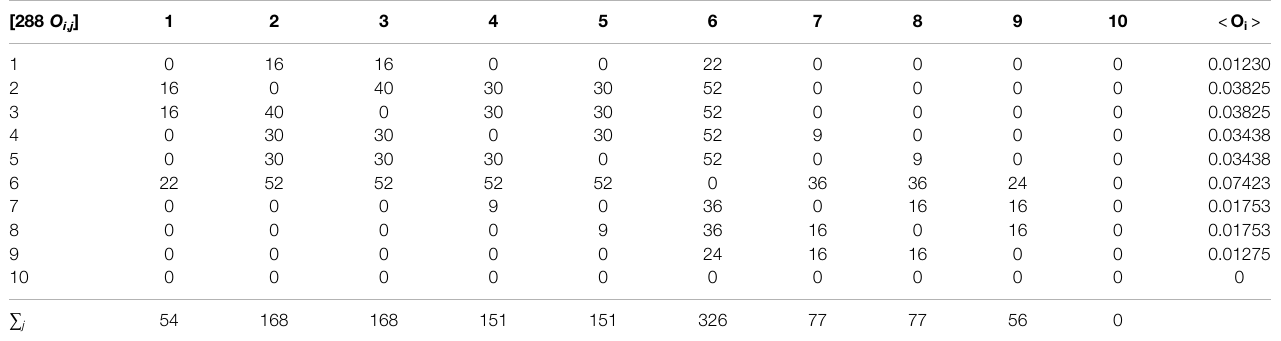
TABLE 3 | [288 O i , j ]: the numerator of the overlap index, Eq. 5 , of the neighboring ] i and ] j nodes; and < O i > , the average overlap index, Eq. 6 . N.B. 288 = 4( N − 1)( N − 2), while (cid:17) i (cid:17) j O i , j =